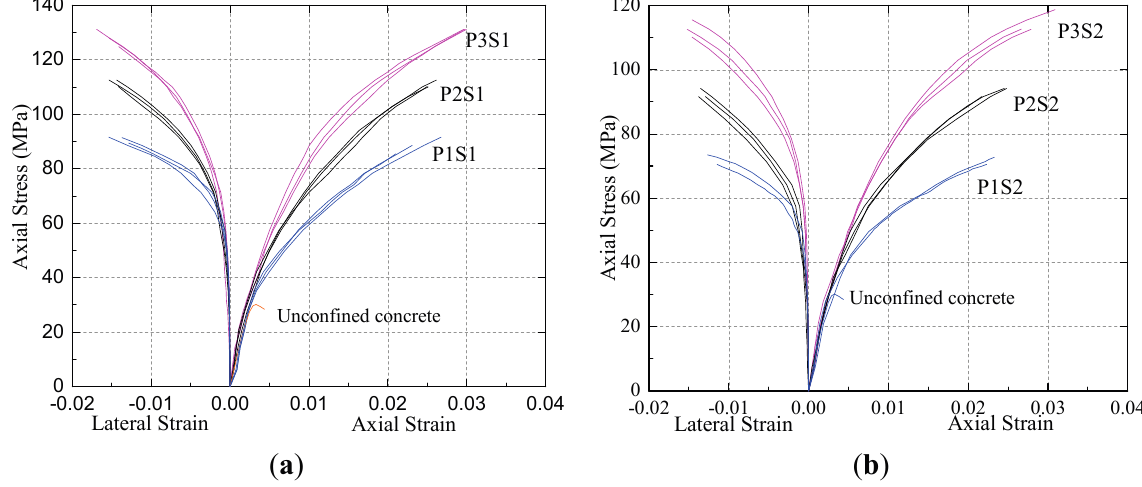
Figure 7. Axial stress versus axial and lateral strain curves for GFRP–SR confined cylinder specimens with SR volumetric ratio of ( a ) 3% and ( b )